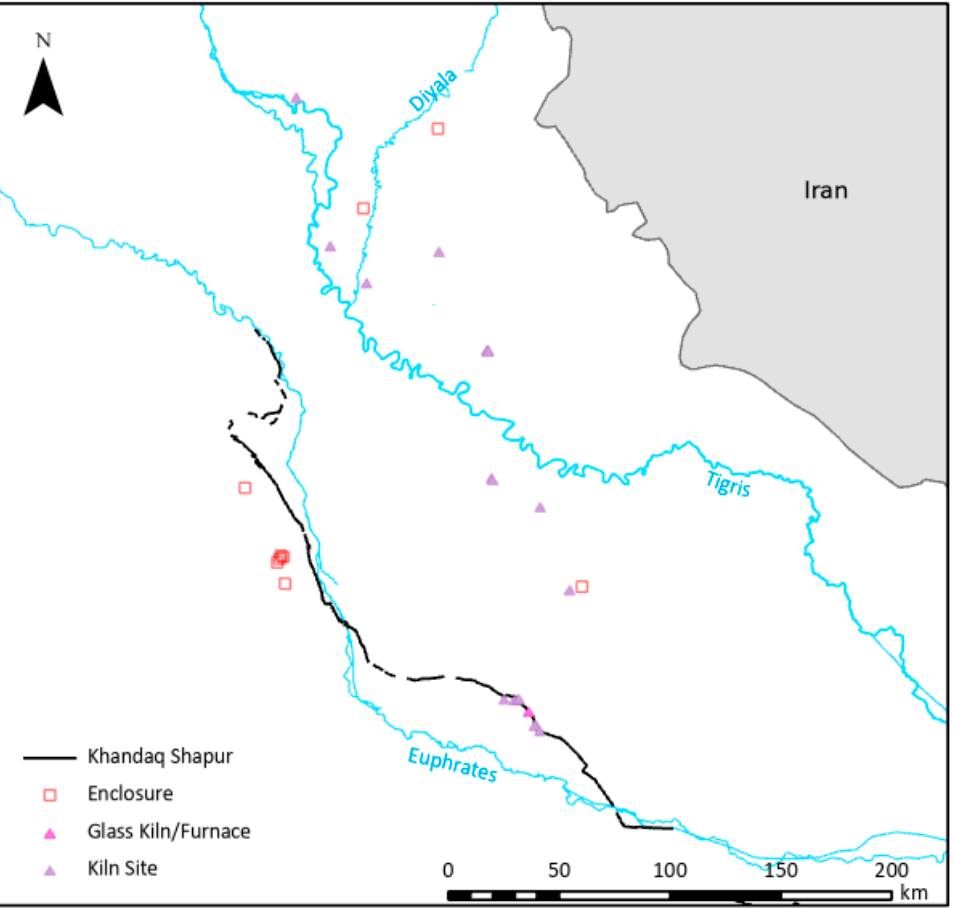
Figure 11. The Khandaq Shapur in relation to the economic landscape represented by ceramic and glass production sites, as well as enclosures typically associated with pastoral activities.